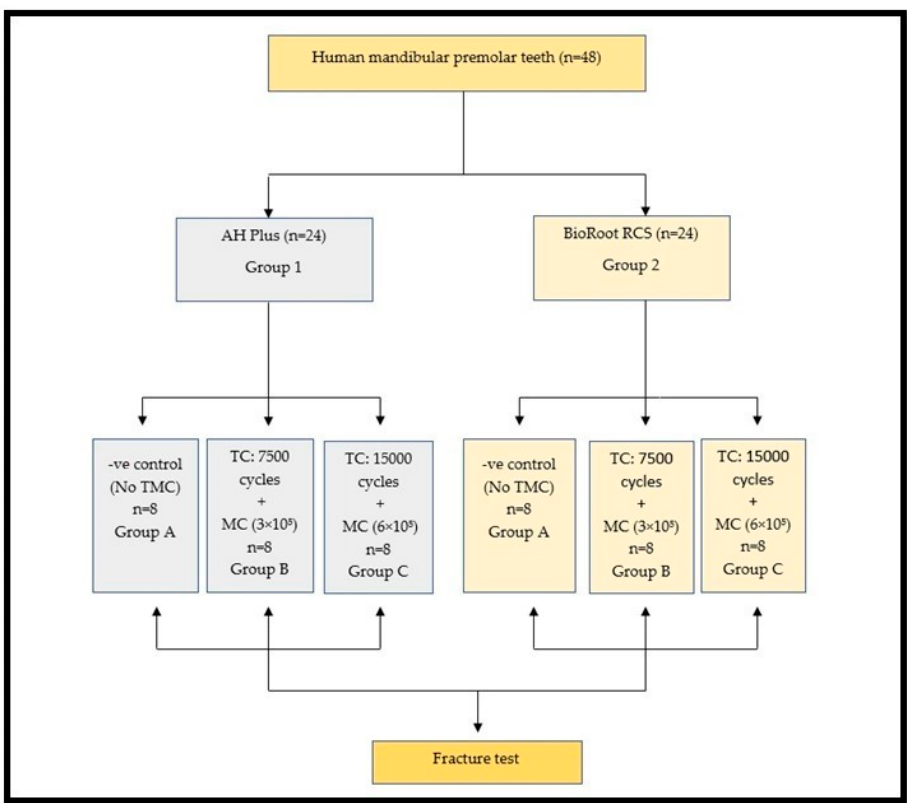
Figure 2. A fl ow chart of the experimental study. TMC: Thermomechanical cycling, TC: Thermal Figure 2. A flow chart of the experimental study. TMC: Thermomechanical cycling, TC: Thermal cycling, MC: Mechanical cycling. cycling, MC: Mechanical cycling.